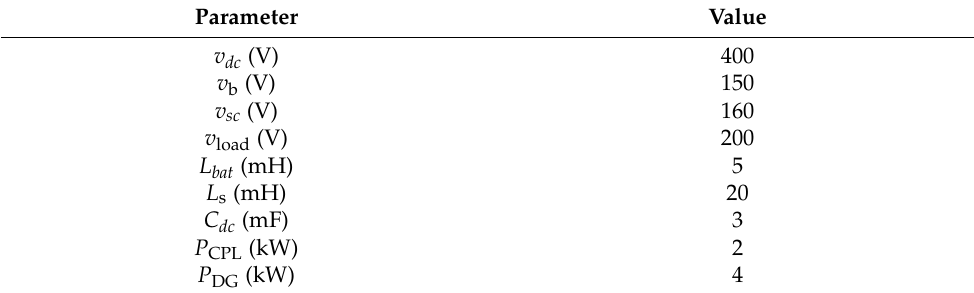
Table 1. Simulation parameters of an islanded DC microgrid.